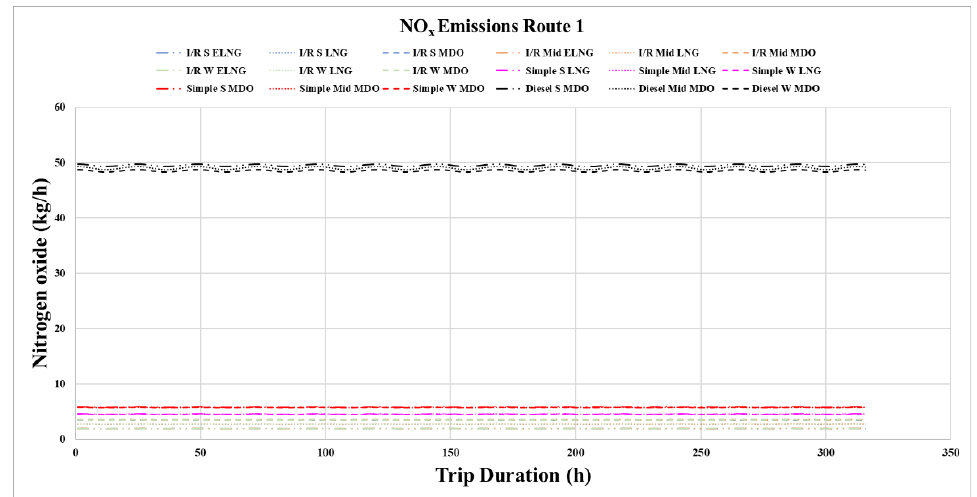
Figure 8. NO x emissions of various propulsion systems of the large container ship travelling between Shanghai and Los Angeles. I/R: intercooler/reheater CCGT; R: reheater CCGT; S simple CCGT; Diesel: two-stroke diesel engine; W: winter; Mid: midseason; S: summer.